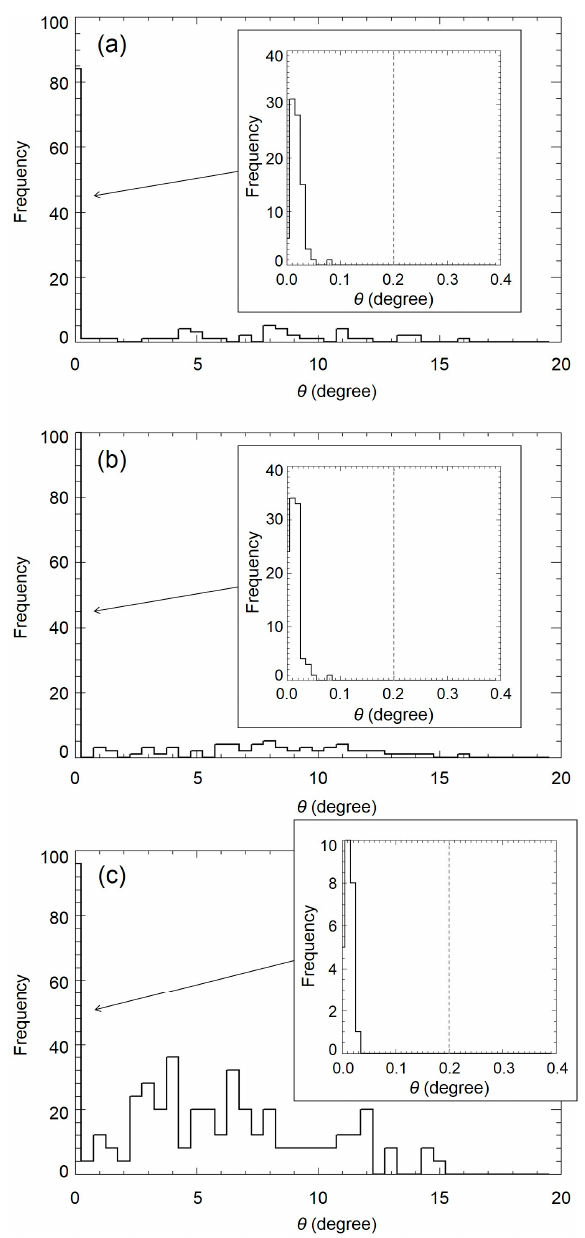
Figure 6. Histograms showing the differences in angles between V C and ˆM (cid:48) V E estimated from all pairs (both correct and incorrect) extracted from the images in ( a ) Figure 4a, ( b ) Figure 4b, and ( c ) Figure 4c. The satellite attitude ˆM (cid:48) was obtained in the proposed scheme.